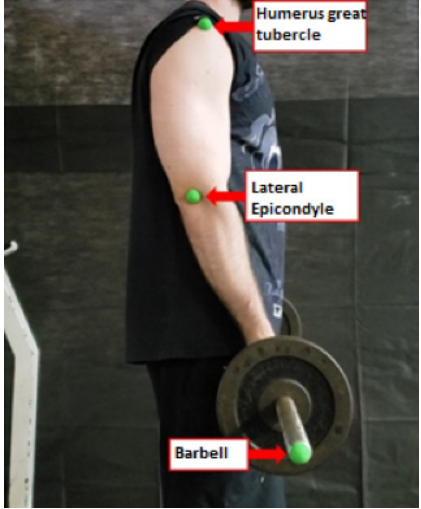
Figure 1. Hemispherical marker locations for data